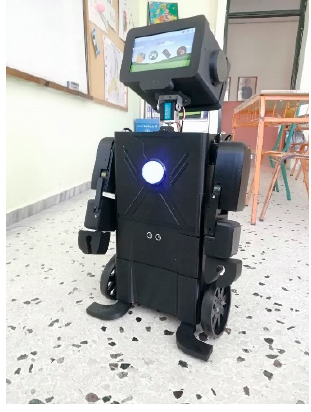
Figure 1. The EI-EDUROBOT.